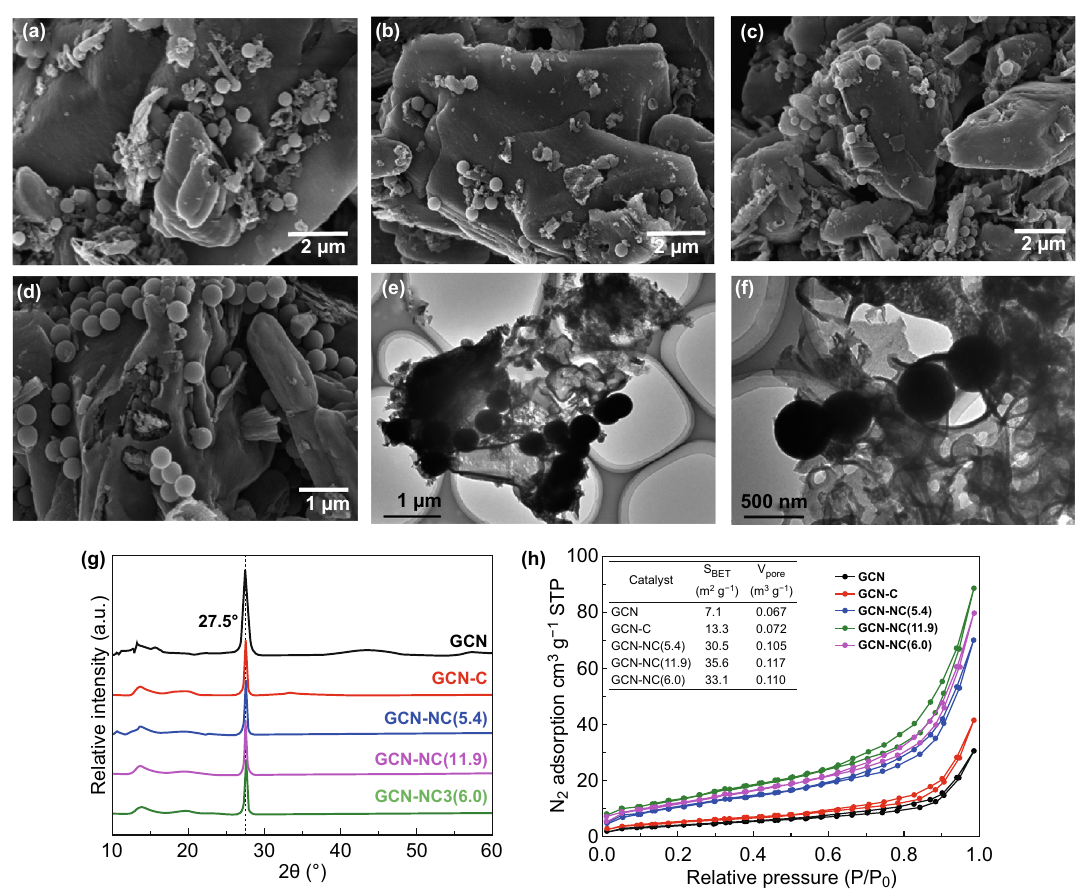
Fig. 1 a SEM images of GCN-C, b GCN-NC(5.4), c GCN-NC(11.9), and d GCN-NC(6.0). e, f TEM images of GCN-NC(6.0). g XRD patterns; h N 2 adsorption–desorption isotherms ( h inset: the textural properties) of